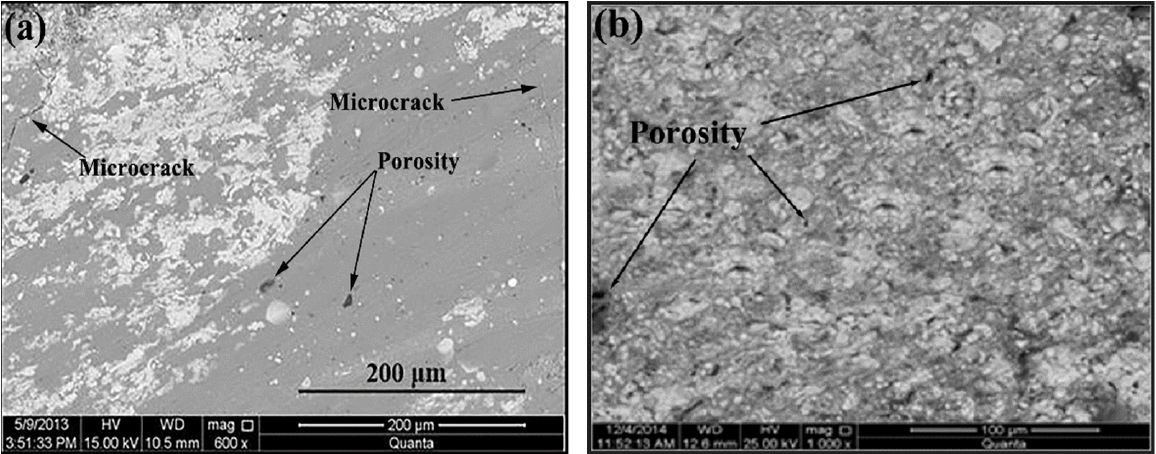
Figure 1. Scanning electron microscopy (SEM) image of TiB 2 coating surface morphology. ( a ) SEM of coating under 600 times, ( b ) SEM of coating under 1000 times.